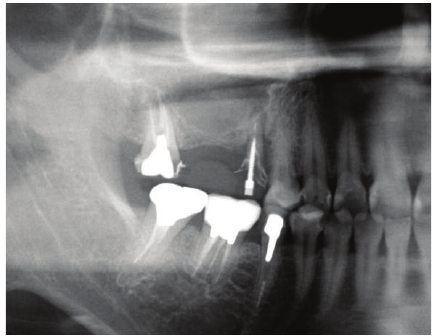
Figure 1: A panoramic radiograph reveals the residual bone height to be low at the first molar